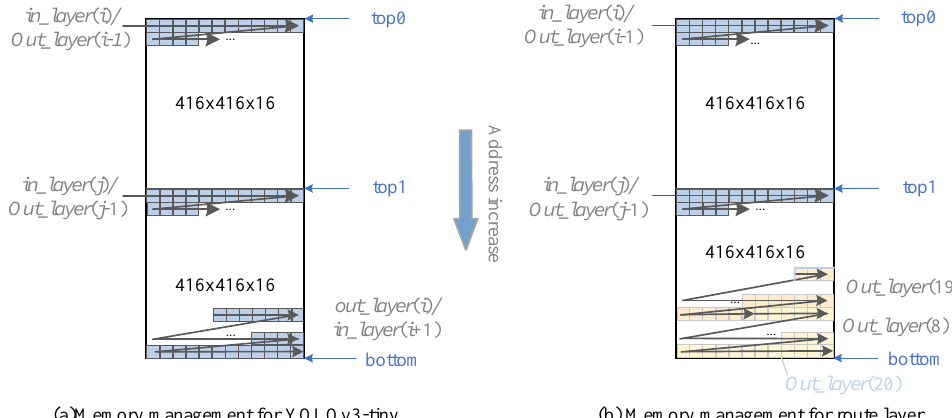
Figure 6. Diagram of the memory interlayer multiplexing